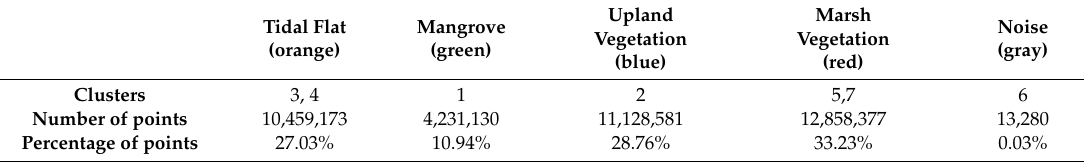
Table 3. Cluster decomposition of the scene for